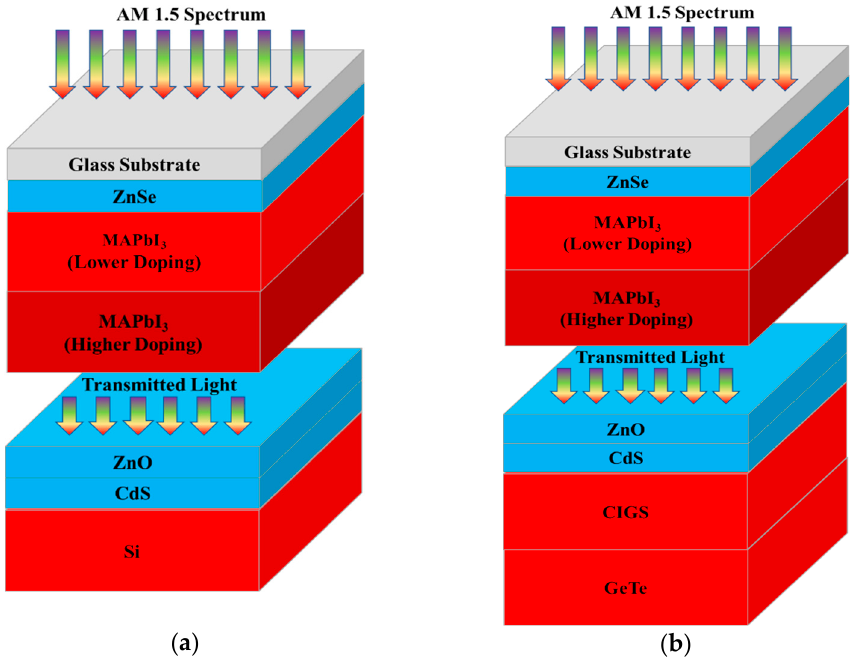
Figure 1. Illustration of structures of the proposed tandem solar cells ( a ) CPSC/Si, and ( b ) CPSC/CIGS-GeTe.